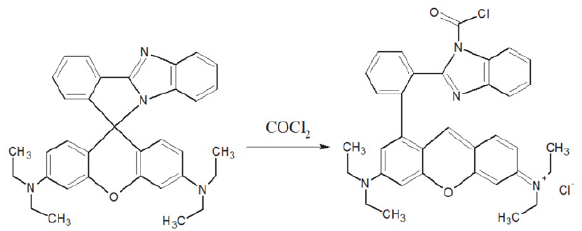
Figure 1: Benzimidazole-rhodamine dye and the end product after the reaction with phosgene are presented.